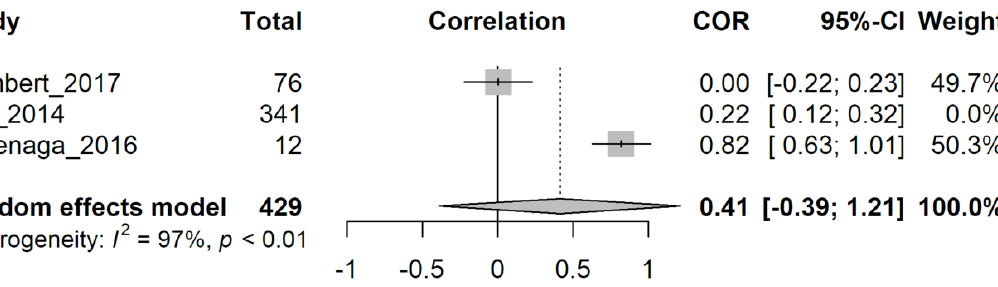
Figure 7. Random effect model analysis of group 2 papers excluding Bell (2014). Study: the first author followed by the year of the study examined. Total: total number of subjects in each group. COR: correlation (extracted from the study) between pain sensations and methylation levels with confidence intervals (grey squares). A 95%-CI: confidence interval for 95% on COR. Weight: Statistical “weight” for each study. In bold characters, results from random effect model analysis are indicated as a graphical diamond on the correlation graph. Heterogeneity: results from heterogeneity test, I 2 , describes the percentage of variation across studies that is due to heterogeneity rather than chance, p : p -value derived from Cochran’s Q test.